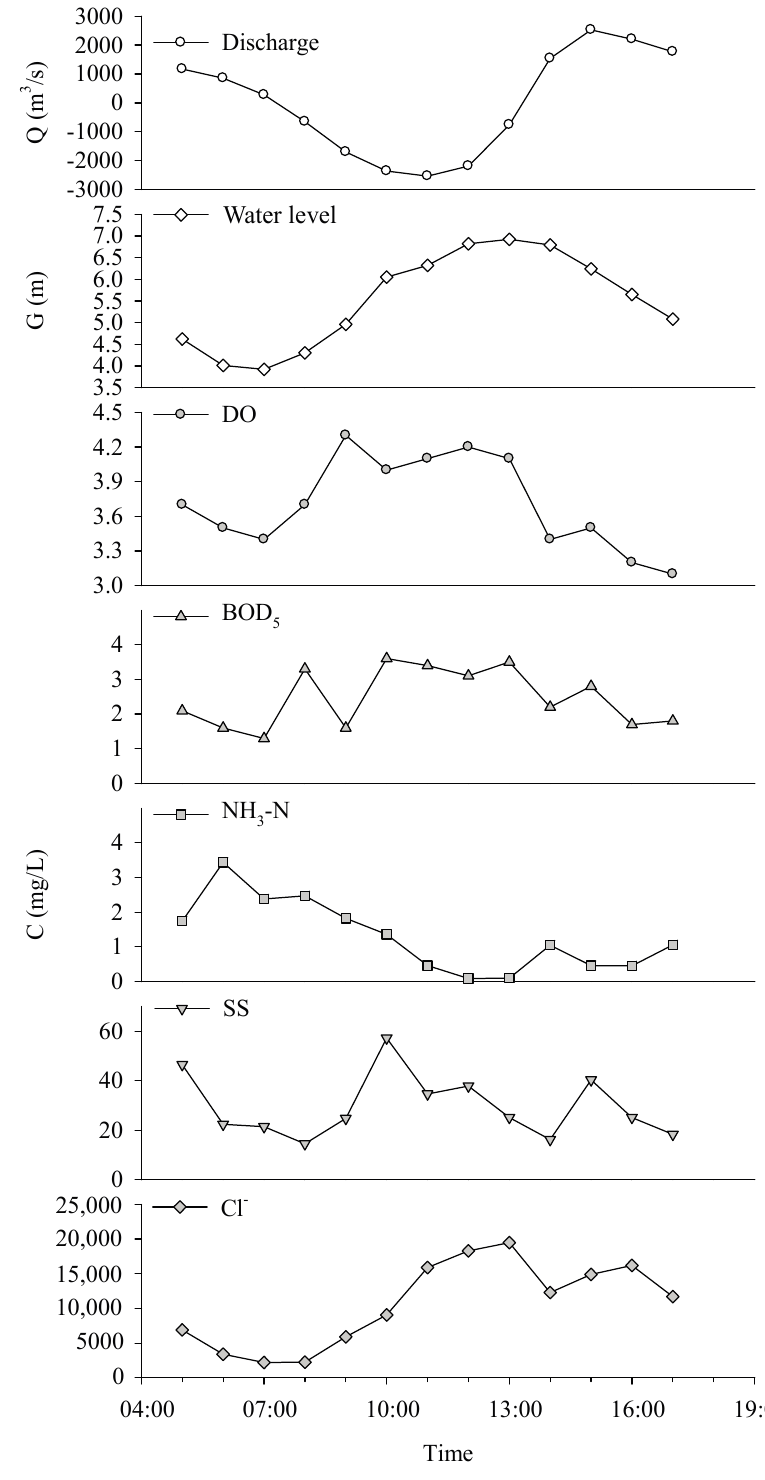
Figure 3. Pollutant concentrations, water stage and discharge measured over a complete tidal cycle at Guando